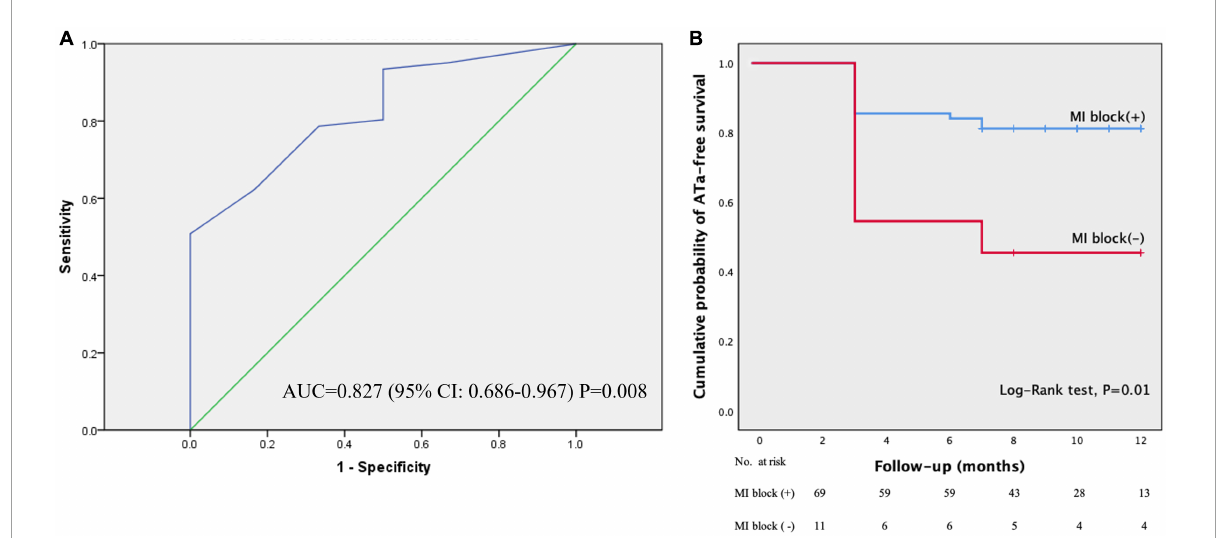
FIGURE5 The ROC curve for the ethanol volume and comparison of ATa-free survival. Panel (A) displayed the ROC curve for the ethanol volume. Area under the curve (AUC) was 0.827, 95% CI: 0.686–0.967, P = 0.008. Panel (B) showed the Kaplan–Meier plots of ATa-free survival in patients with MIth block and those without during one year’s follow-up. The ATa-free survival was significantly higher in patients with successful MIth block than that in those without (Log-rank test, P = 0.01). ATa, atrial